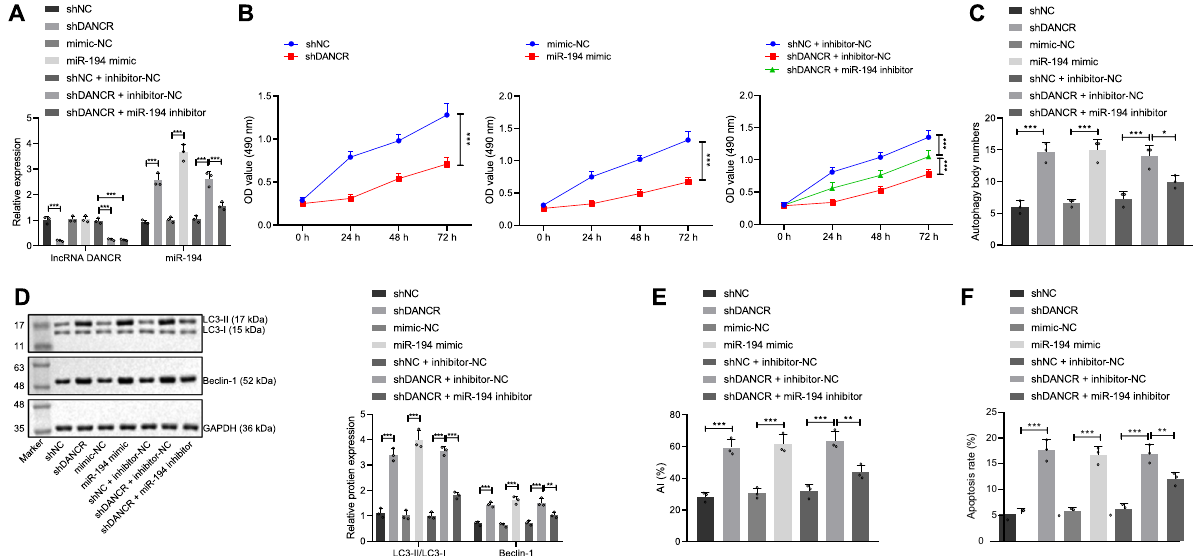
Fig. 5 DANCR knockdown upregulates miR-194 expression, thereby accelerating GC cell autophagy. A qRT-PCR to measure the mRNA expression of DANCR and miR-194 in transfected cells; B MTT assay to detect the viability of transfected cells; C Quantitative analysis of autophagy of transfected cells under the observation of transmission electron microscope; D western blot assay to measure the expression of autophagy-related proteins (LC3-I, LC3-II, and Beclin-1); E TUNEL assay to assess TUNEL-positive apoptotic cells; F Flow cytometric detection of apoptosis rate of the transfected cells. * p < 0.05, ** p < 0.00, *** p < 0.0001. The measurement data are summarized by mean ± standard deviation. Data in A – F were analyzed by one-way ANOVA with Tukey post hoc test. Statistical analysis in relation to time-based measurements in B was realized using repeated measures ANOVA, followed by a Bonferroni ’ s post hoc test. Cellular experiment was repeated three